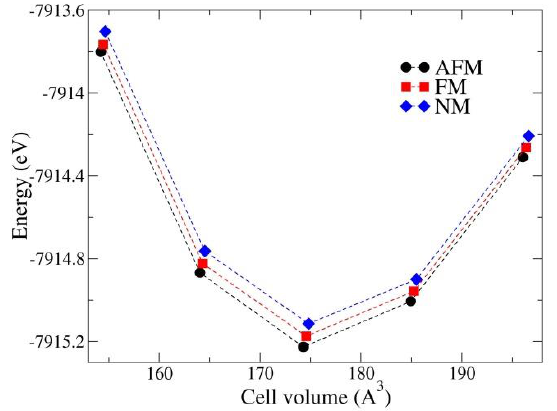
Figure 2. Variation in the total energy as a function of the cell volume calculated for the AFM, FM, and NM states of the CuPPD structure with the PBE method. and NM states of the CuPPD structure with the PBE method.